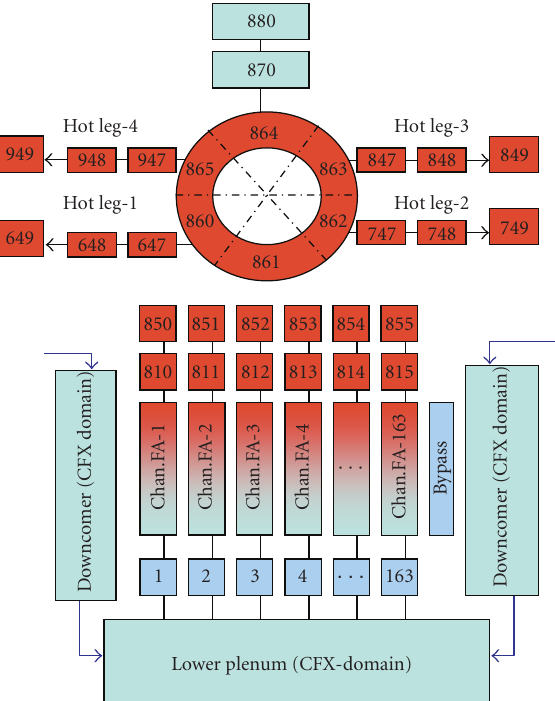
Figure 11: Sketch of the RPV Model with the CFX and RELAP5 domain.